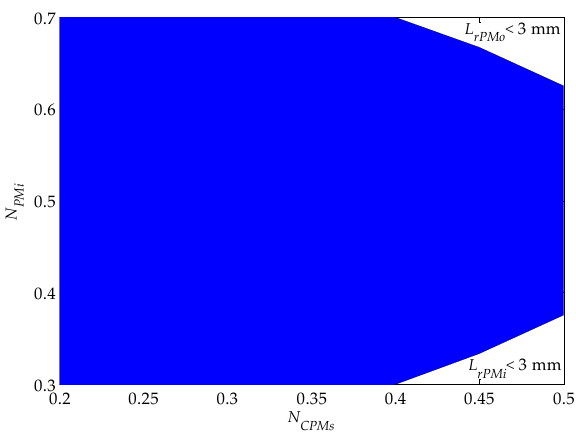
Figure 8. Limitation of the radial length of the PMs given by inequalities 3 and 4 in Equation (16) as a function of the parametric variables N PMi and N CPMs , where L rPMi = ( R oPMi − R iPMi ) is the radial length of the inner PMs and L rPMo = ( R oPMo – R iPMo ) is the radial length of the outer PMs. The inequalities given by Equation (16) could be different from the ones that were set; they are basically criteria imposed by the designer. For the case under study, it was found that P = 4 and L z / L zW = 0.59; thus, both criteria